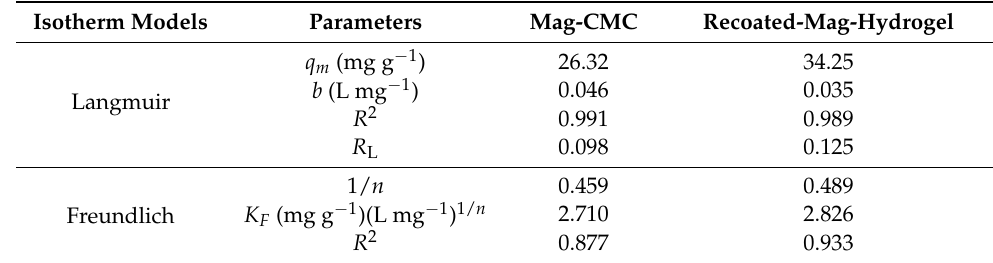
Table 1. Adsorption isotherm parameters for MB